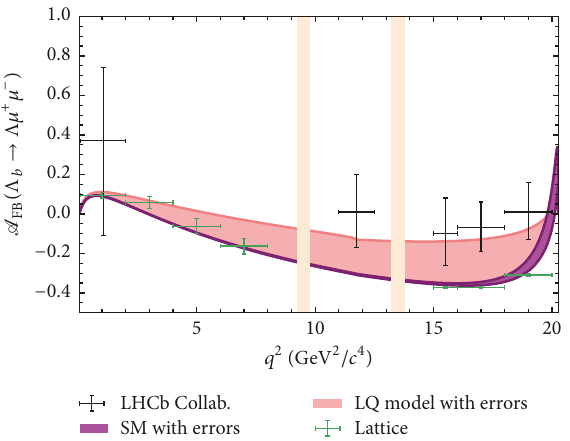
Figure 6: The dependence of the differential branching ratio on 𝑞 2 forthe Ξ 𝑏 → Ξ𝜏 + 𝜏 − transitionintheSMandLQmodels.Thevertical shaded band indicates the charmonia veto region.